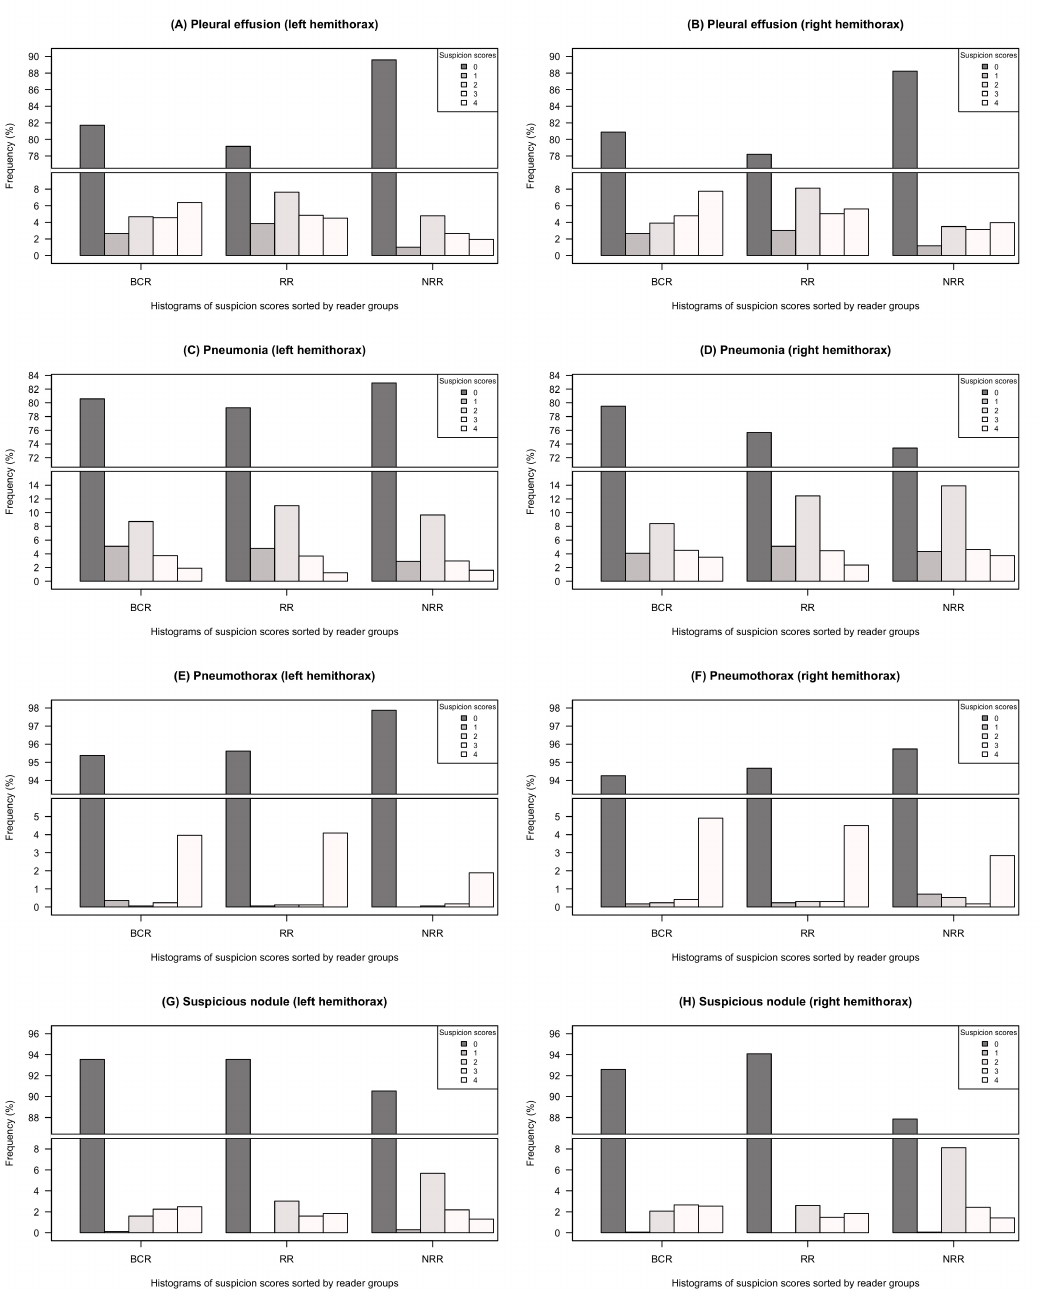
Figure 2. Distribution of Likert-scale based choices (0–4) separated by groups BCR (board-certified radiologists), RR (radiology residents) and NRR (non-radiology residents—Graphs contain gaps in y -axes since option 0 (no suspicion of pathology) was chosen most frequently in all pathologies and groups ( A – H ). Frequency is given in % of all individual answers in the reading group. Individual choice distribution can be found in the Supplement (Figure